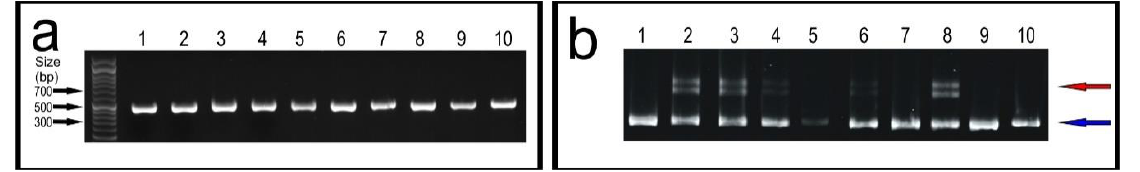
Figure 7. Screening for DNA modifications. ( a ) per amplicons from individual embryos in a 1.2% agarose gel. ( b ) 15% PAGE gel heteroduplex assay of samples reported in ( a ). Blue arrow indicates the homoduplexes and red arrow the heteroduplexes.